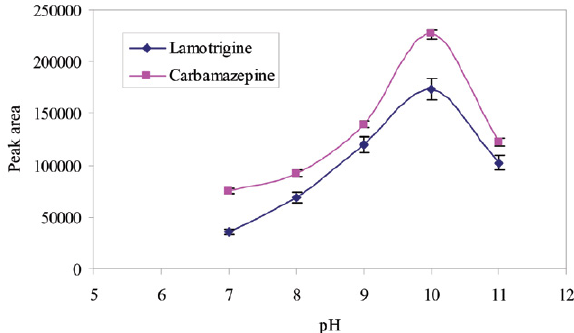
Figure 2. Effect of pH on the extraction efficiency, Extraction con- ditions: extraction solvent: [C4MIM][PF6], extraction solvent vol- ume: 30 µL; dispersive solvent: methanol; dispersive solvent vol- ume: 100 µL; concentration of NaCl ( w/v ): 1.0%